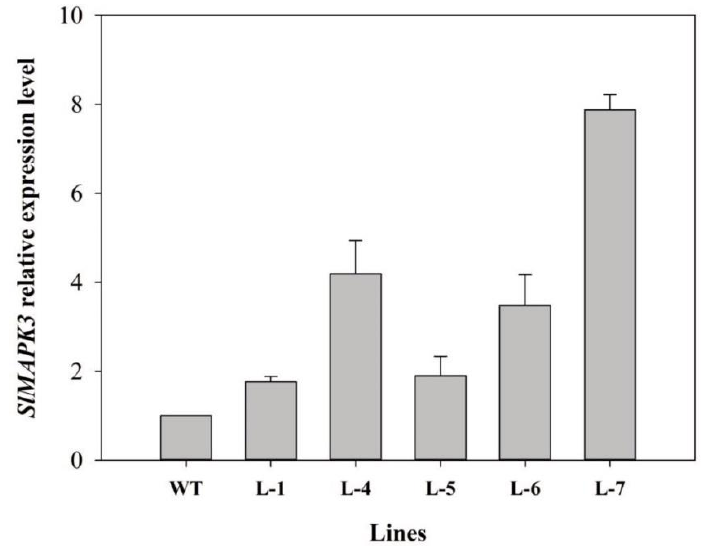
Figure 2. Expression levels of SlMAPK3 in wild-type and transgenic lines. Expression data were normalized with SlMAPK3 expression in WT as 1. Error bars show the standard error between three replicates.